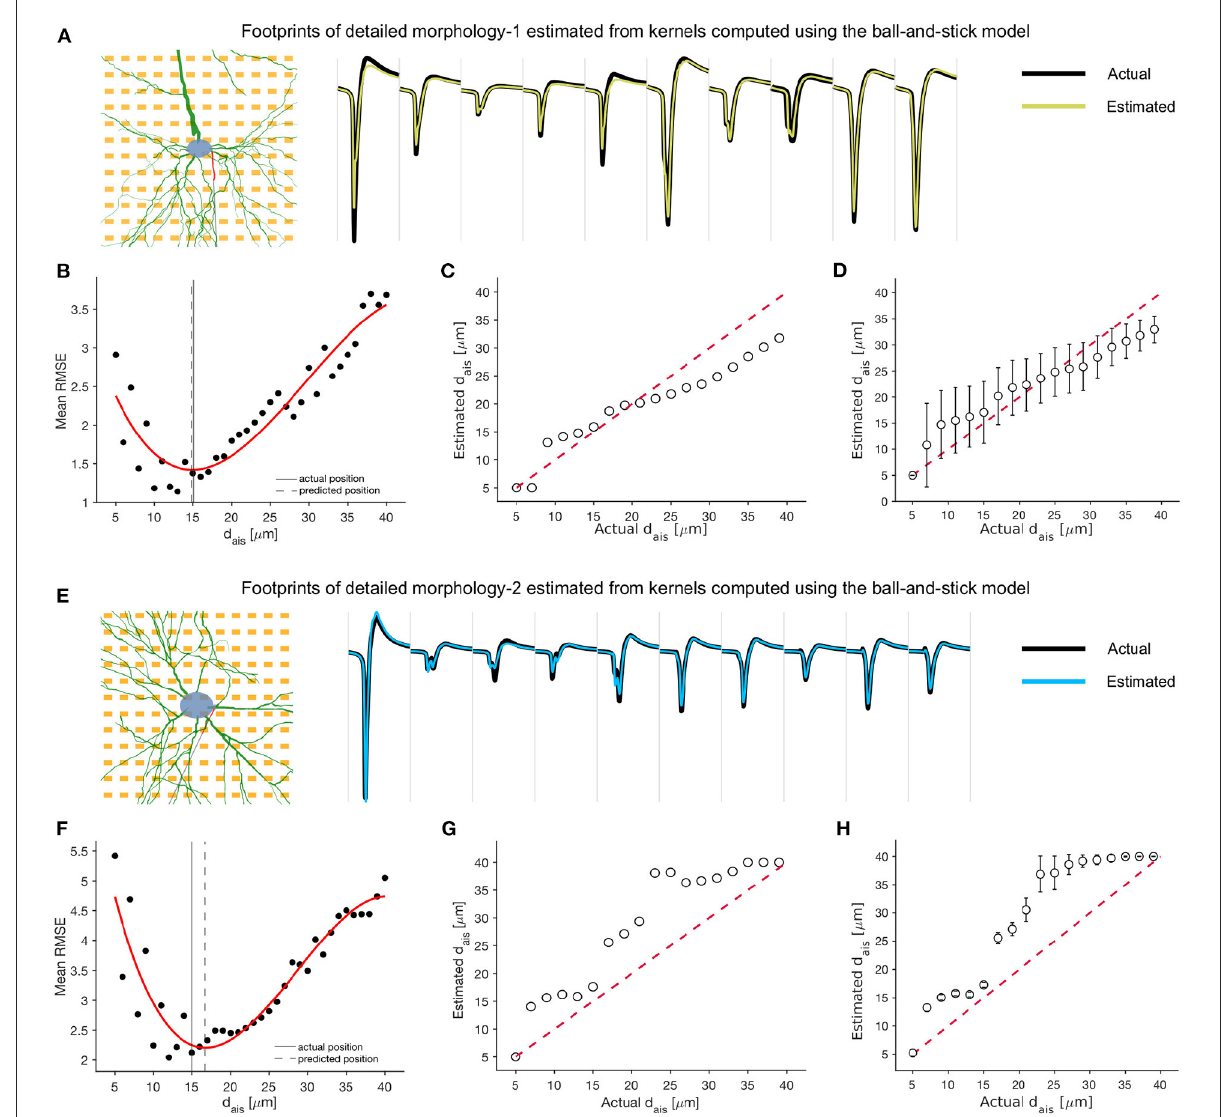
FIGURE7 Kernel functions, derived from the minimal ball-and-stick model, may be used to detect and predict AIS relocation relative to baseline extracellular footprints, even when the specific baseline morphology is unavailable. (A,E) Waveforms from 10 selected channels of the extracellular footprint of the detailed morphology models corresponding to an AIS position of 15 µ m (black) and traces estimated by the optimal kernel functions (yellow: DM1, blue: DM2). (B,F) The mean RMS error between the actual and estimated extracellular footprint averaged over electrodes and computed using kernel functions corresponding to various AIS positions. The error is lowest around the actual AIS position (15 µ m). A cubic polynomial was fitted (red) to the errors, and the putative AIS position was estimated as the one corresponding to the minimum of this fitted function. The traces in [ (A) , yellow] and [ (E) , blue] were estimated using this optimal kernel. (C,G) Comparison of actual and estimated AIS positions for a single orientation ( θ = 0 ◦ ). Each estimate was the mean over four jittered soma positions. (D,H) The mean and standard deviation of each estimate, averaged over all rotations of the neuron